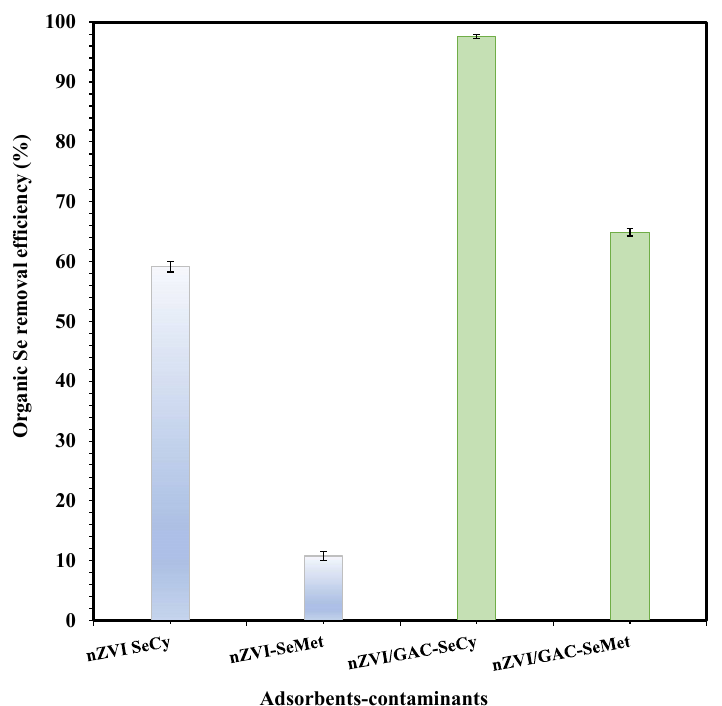
Figure 4. Compare adsorption capacity of synthesized nZVI and nZVI/GAC for removal of SeCys and SeMet from aqueous solution: Organic selenium initial concentration 0.5 mg/L, adsorbent ratio 3 g/L, pH 7.0, at 25 °C for 6 h period.